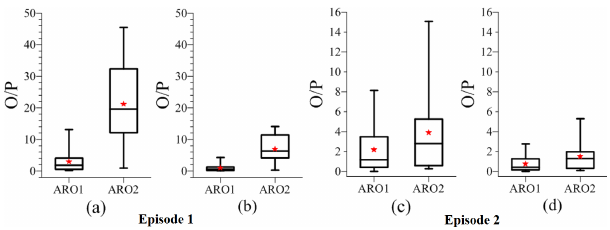
Figure 3. Box–whisker plot of the observed-to-predicted ( O/P ) ra- tios of aromatic compounds during the two analyzed episodes. The observed data were measured at 14:00LST every Thursday by gas chromatography and mass spectrometry at three sites (Beijing, Xin- glong and Yucheng). (a, c) Original emissions of aromatic com- pounds and (b, d) a 3-fold increase in the emissions of aromatic compounds. The red stars show the mean O/P